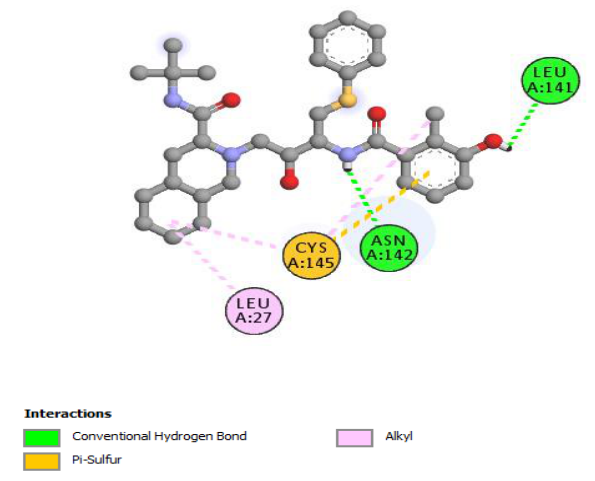
Figure 5. 2D interactions of nelfinavir with